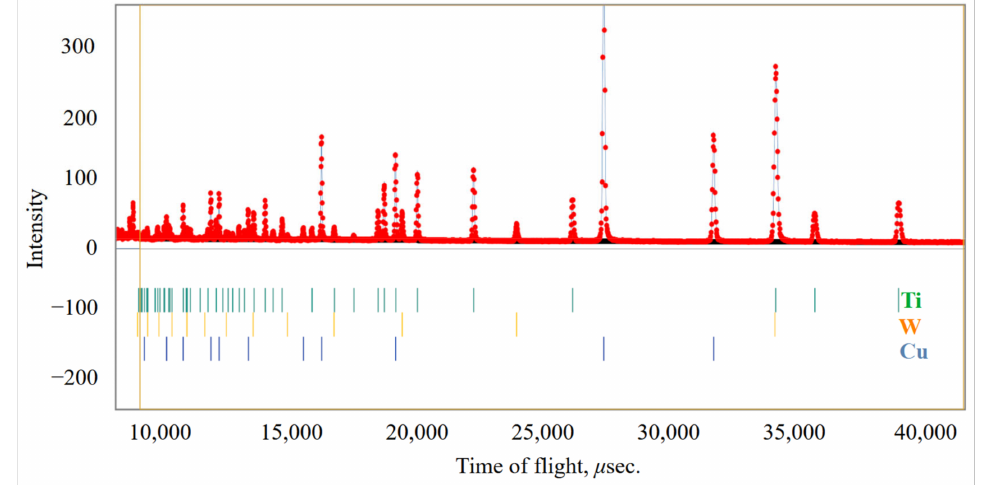
Figure 6. One example of the diffraction profile measured using the time-of-flight method of TKUMI. These diffraction profiles were peak-fitted using the Z-Rietveld